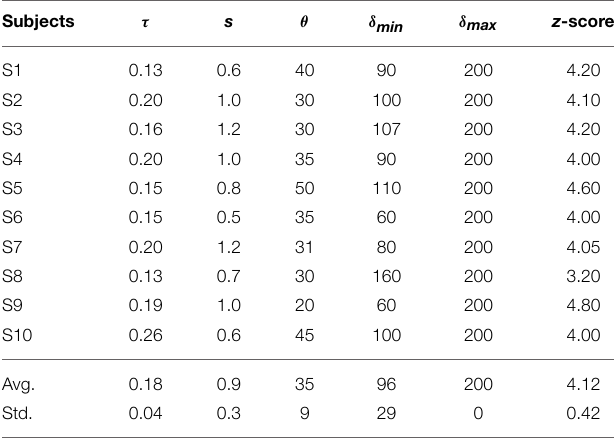
TABLE 4 | Cingulum-specific tractography parameters and rs-fMRI z -scores used for the assessment of inter-subject variability. Subjects